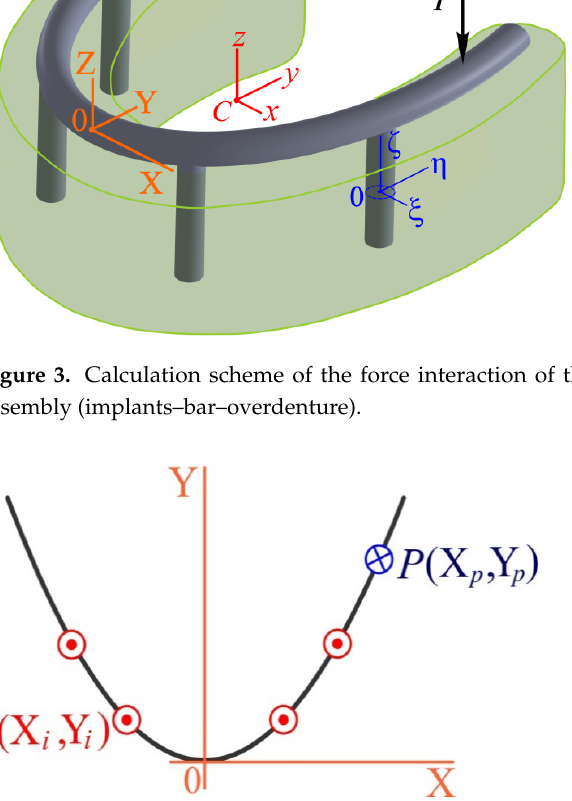
Figure 4. Original coordinate system (the OZ axis is directed at the reader): red—implants, blue—pole.